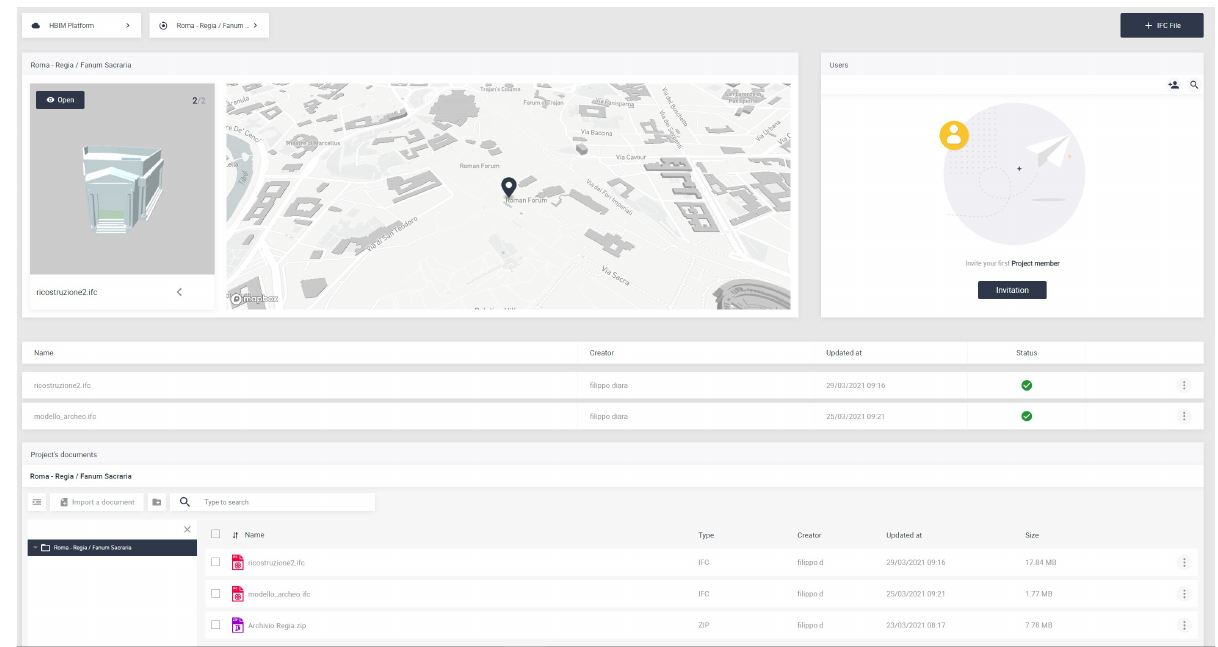
Figure 1. BIMData page account. Sections: IFC model; localization; invitation for users and sources archive.